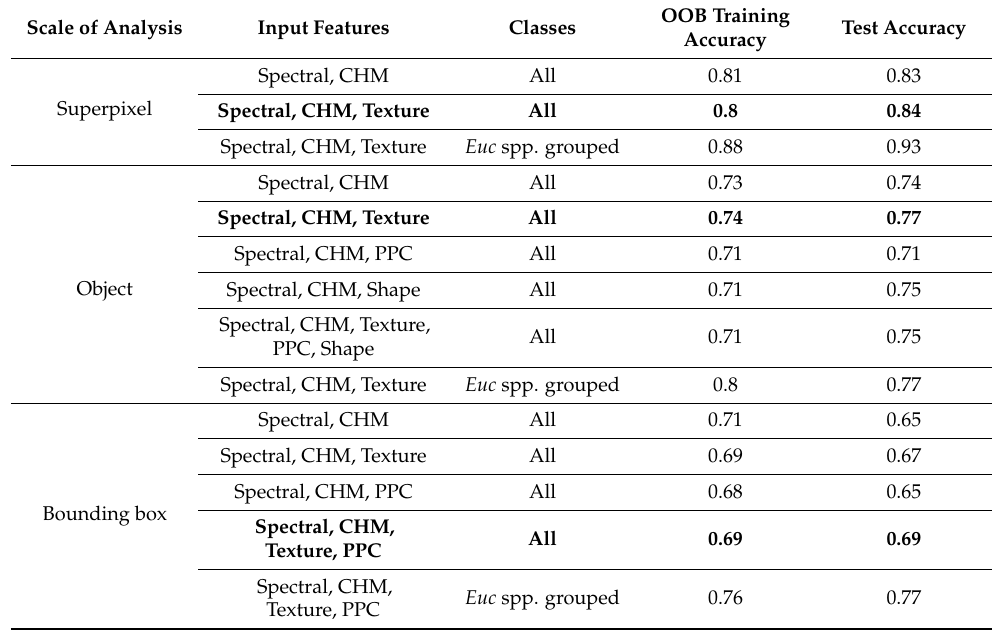
Table 5. Classification accuracies using spectral and incremental addition of Texture, Shape, and PPC features (when applicable). Input features and highest classification accuracy at each scale are in bold. Classification with Eucalyptus ( Euc ) spp. grouped in a class was performed with these input